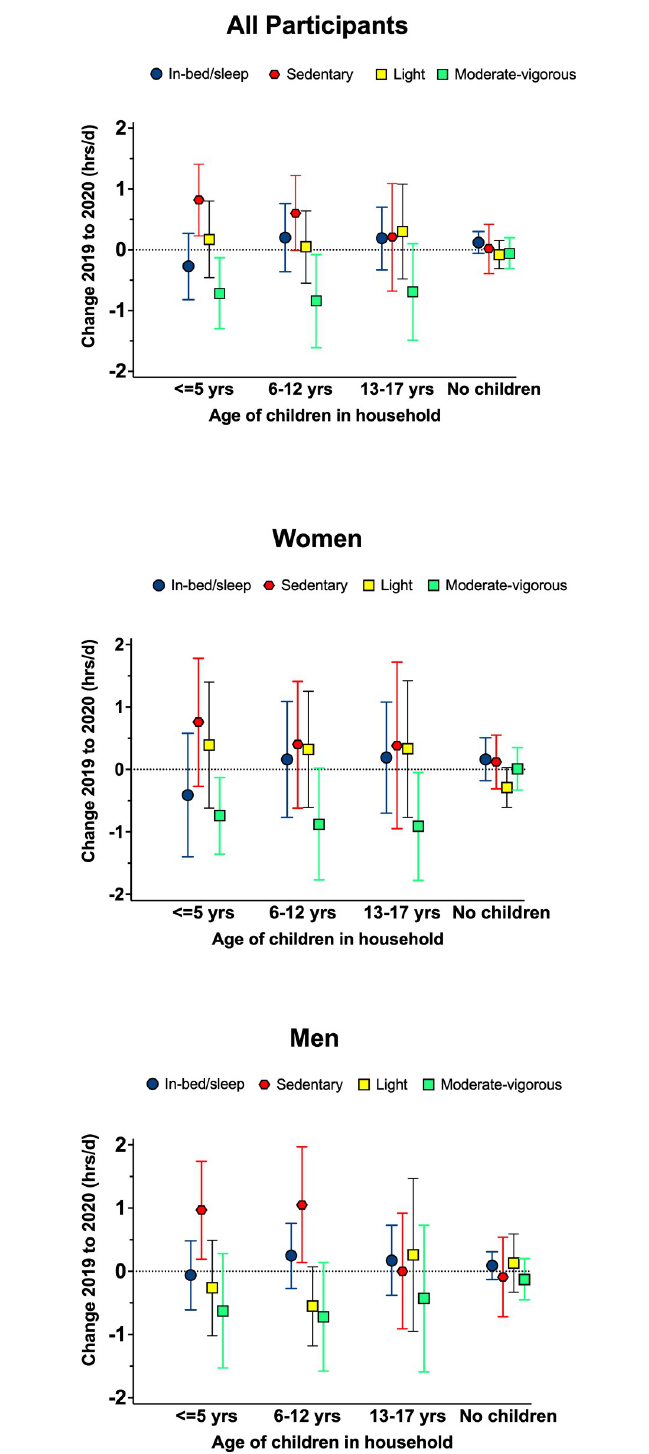
Fig 2. Mean differences (95%CIs) between pre-pandemic in Fall 2019 and Fall 2020, in daily behaviors in all participants and men and women, by the presence of children in the household.